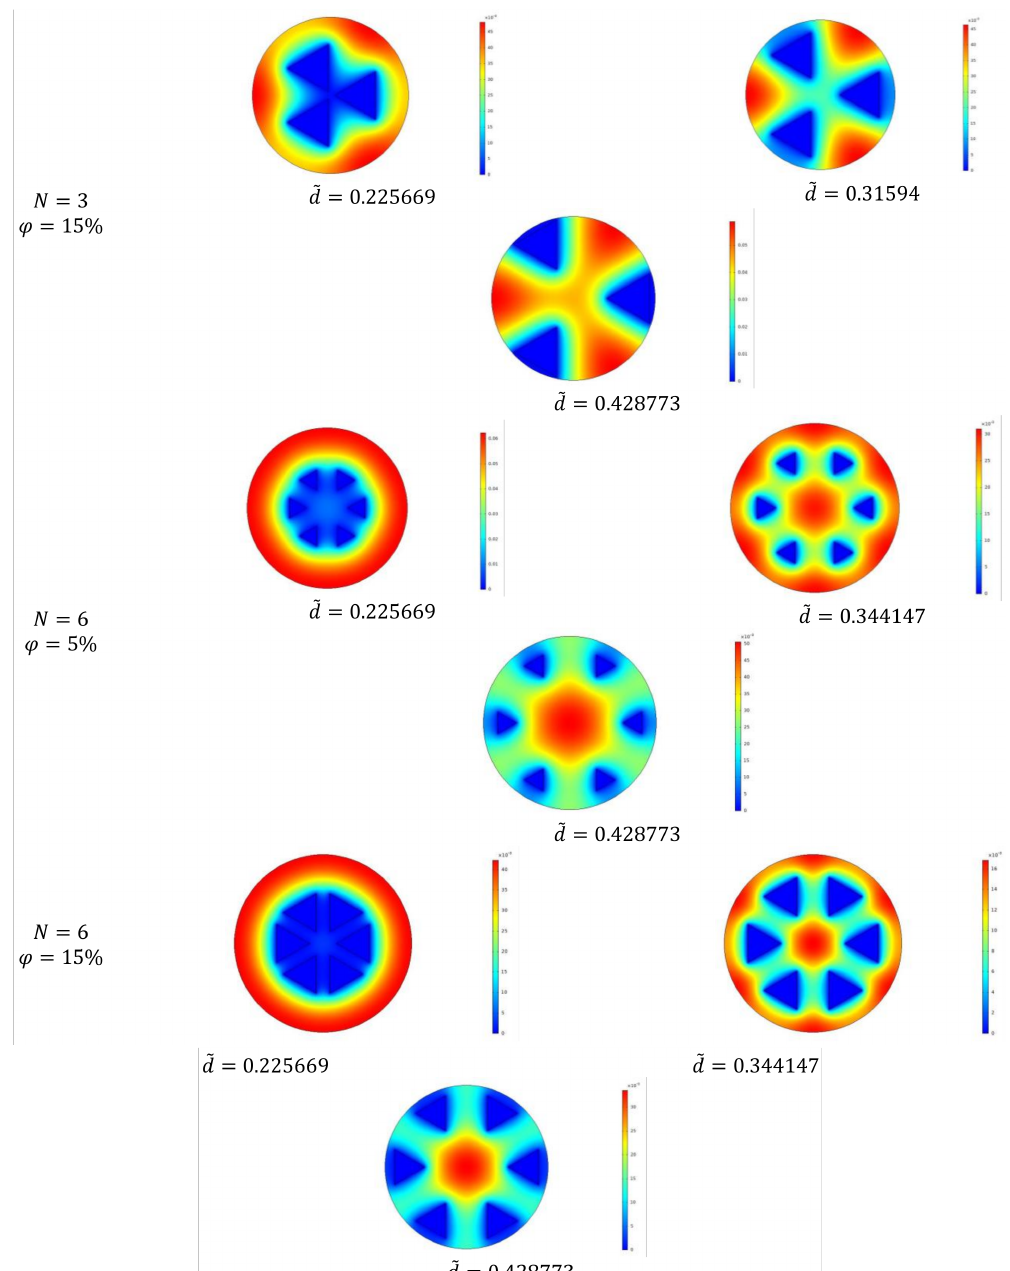
Figure 10. A dimensionless temperature cloud chart of model